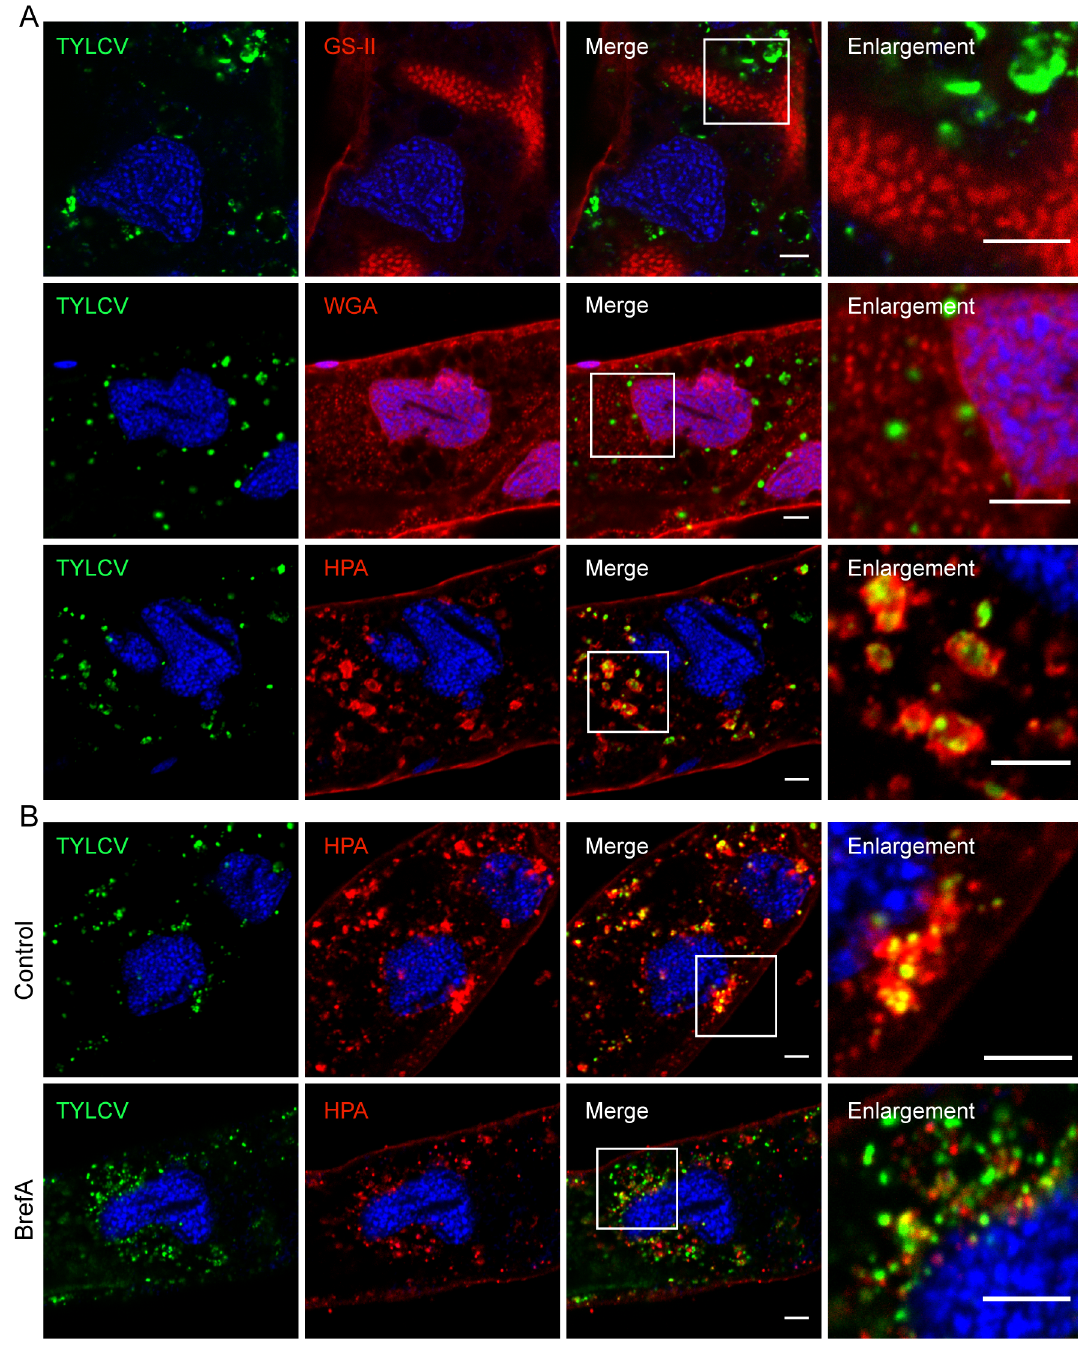
Fig 3. Subcellular localization of TYLCV in the epithelial cells of whitefly midgut. (A) Confocal microscopy images showing the colocalization of TYLCV with HPA-labeled structures. Midguts of whiteflies exposed to TYLCV-infected tomato plants for a 3 d AAP were dissected and prepared for immunofluorescence. TYLCV was identified using a specific antibody against its coat protein, the only known structural protein of TYLCV. Lectins GS-II, HPA, and WGA were used to label different kinds of glycoproteins. Colocalization between TYLCV and GS-II, WGA, and HPA-labeled structures were quantified as 0.04 ± 0.02, 0.08 ± 0.01, and 0.43 ± 0.02, respectively (Pearson’s coefficient, mean ± SE, n = 14–20). Scale bar, 5 μ m. (B) Whiteflies that had been fed with BrefA and control whiteflies that had been fed with solvent ethanol were transferred to TYLCV-infected plants for 3 d AAP. BrefA disrupted the colocalization between TYLCV and HPA. Colocalization between TYLCV and HPA in whiteflies fed with solvent or BrefA were quantified as 0.48 ± 0.02 and 0.20 ± 0.02, respectively (Pearson’s coefficient, mean ± SE, n = 10). Scale bar, 5 μm. Representative images that were used to generate the data are provided in S6 Fig.